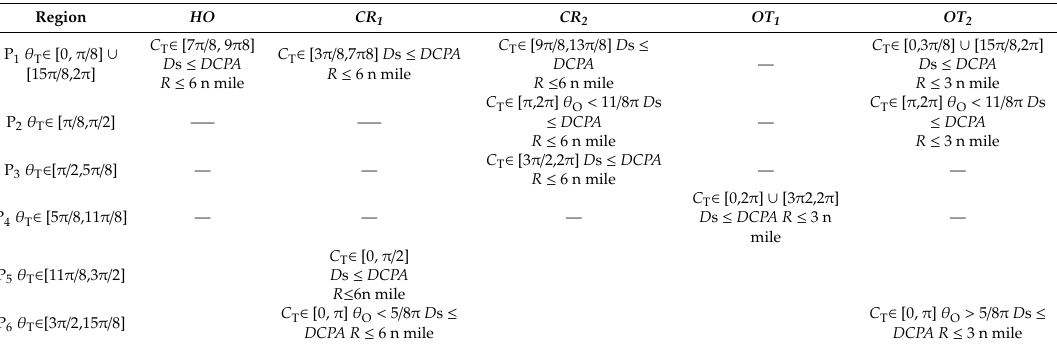
Table 2. The quantified criteria for specific encounter situations.